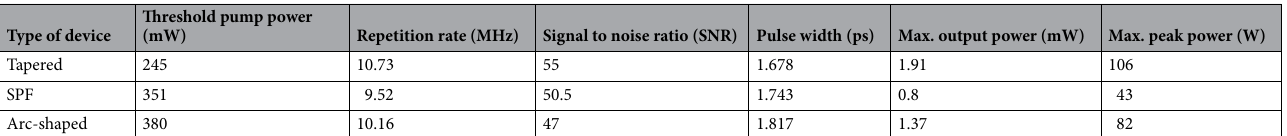
Table 3. Summary of the optical characteristics of the TDFL with each mode-locking device in the fundamental